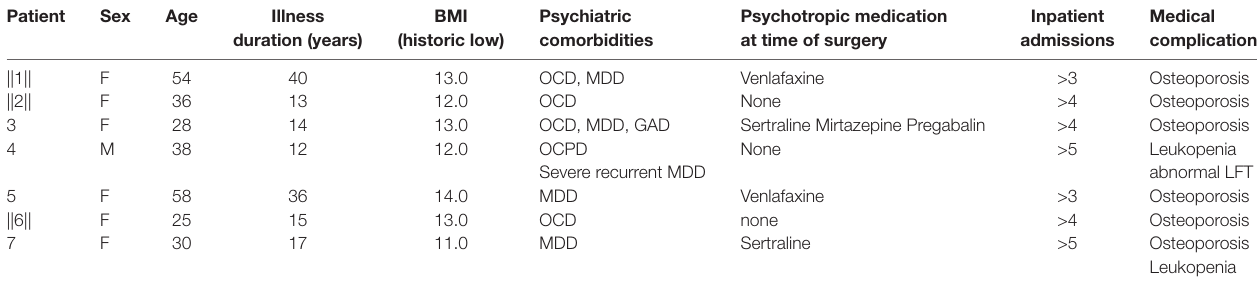
TABLE 1 | Demographic and clinical patient